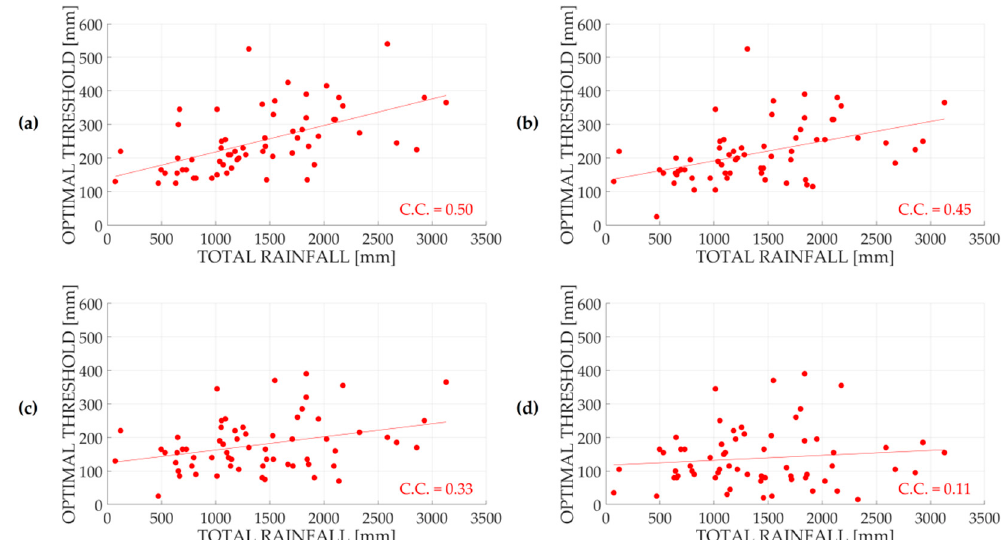
Figure 5. The optimal thresholds for every country object of study obtained for four different conditions: The results refer to a 24-h aggregation interval and were obtained with a false alarm cost equal to 1. Regarding the missed alarm cost, the following costs were used: 2 ( a ), 5 ( b ), 10 ( c ) and 20 ( d ).